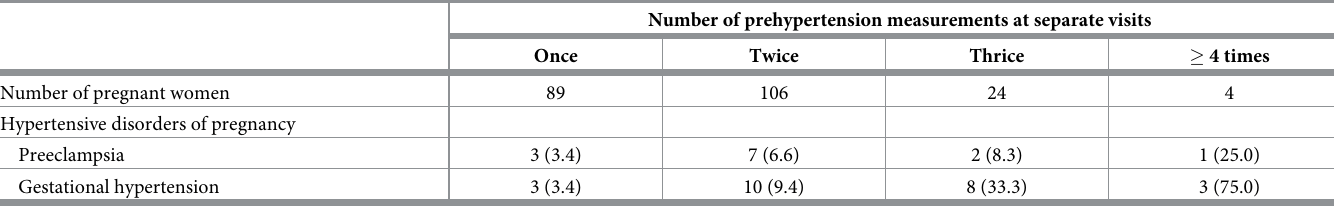
Table 2. Frequency of the occurrence of hypertensive disorders of pregnancy according to the number of prehypertension measurements at separate hospital visits in pregnant women with prehypertension before 20 weeks of gestation. Number of prehypertension measurements at separate